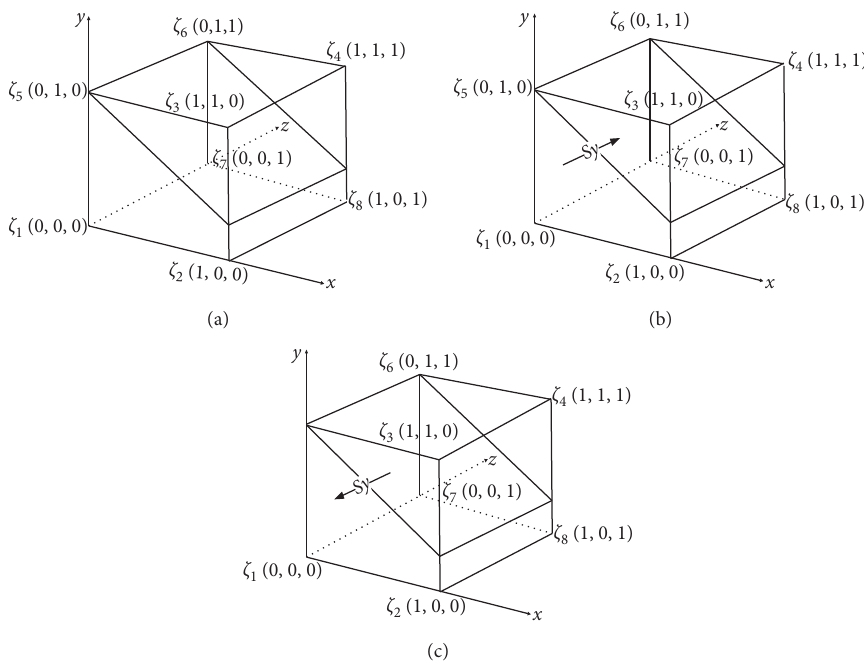
Figure 8: Phase diagram of local government stability